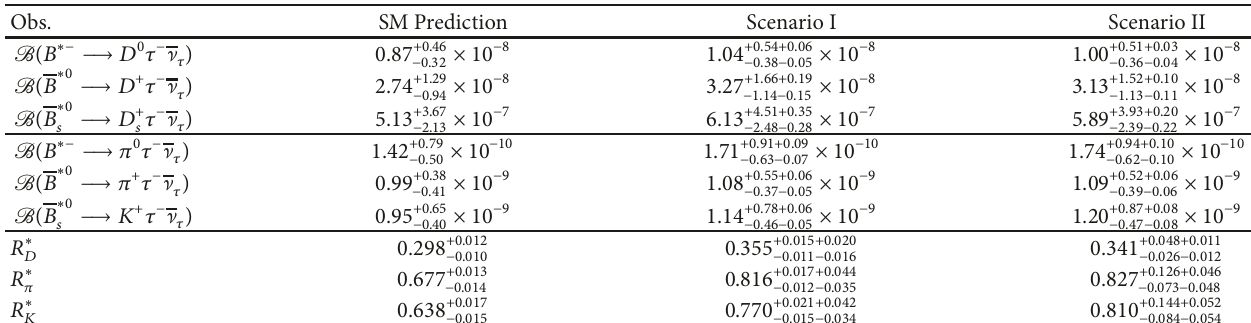
∗ 󳨀→ 𝑃𝜏 − ] 𝑅 ∗ 𝜏 decays and 𝑃 within the SM and the two scenarios. The first